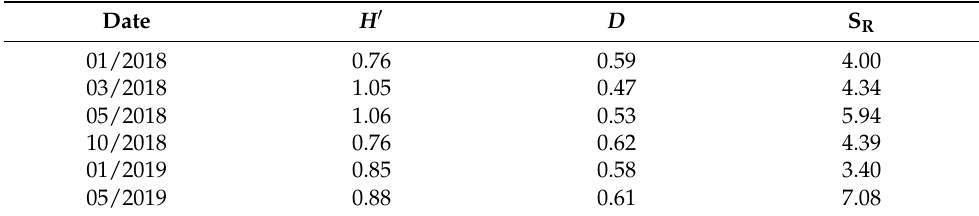
Table 5. Diversity indices for vertebrates identified from mosquito blood meals collected at six different trapping dates in the San Juan Metropolitan Area, Puerto Rico. The indices listed are Shannon’s entropy ( H (cid:48) ), Gini–Simpson ( D ), and rarefied species richness ( S R